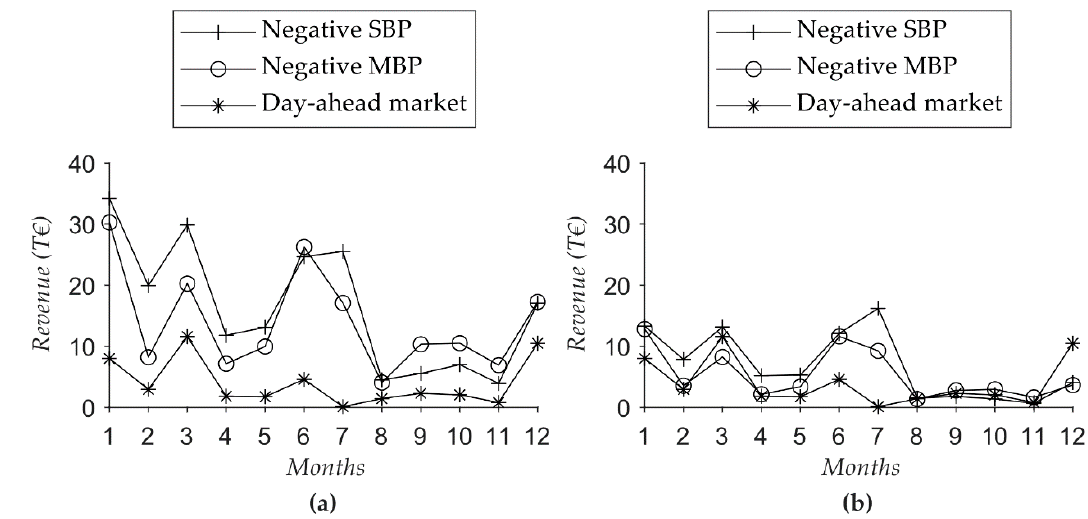
Figure 7. Revenues through operating with bivalent energy: ( a ) Optimal bidding strategy and minimum taxes; ( b ) Realistic bidding strategy and minimum taxes.